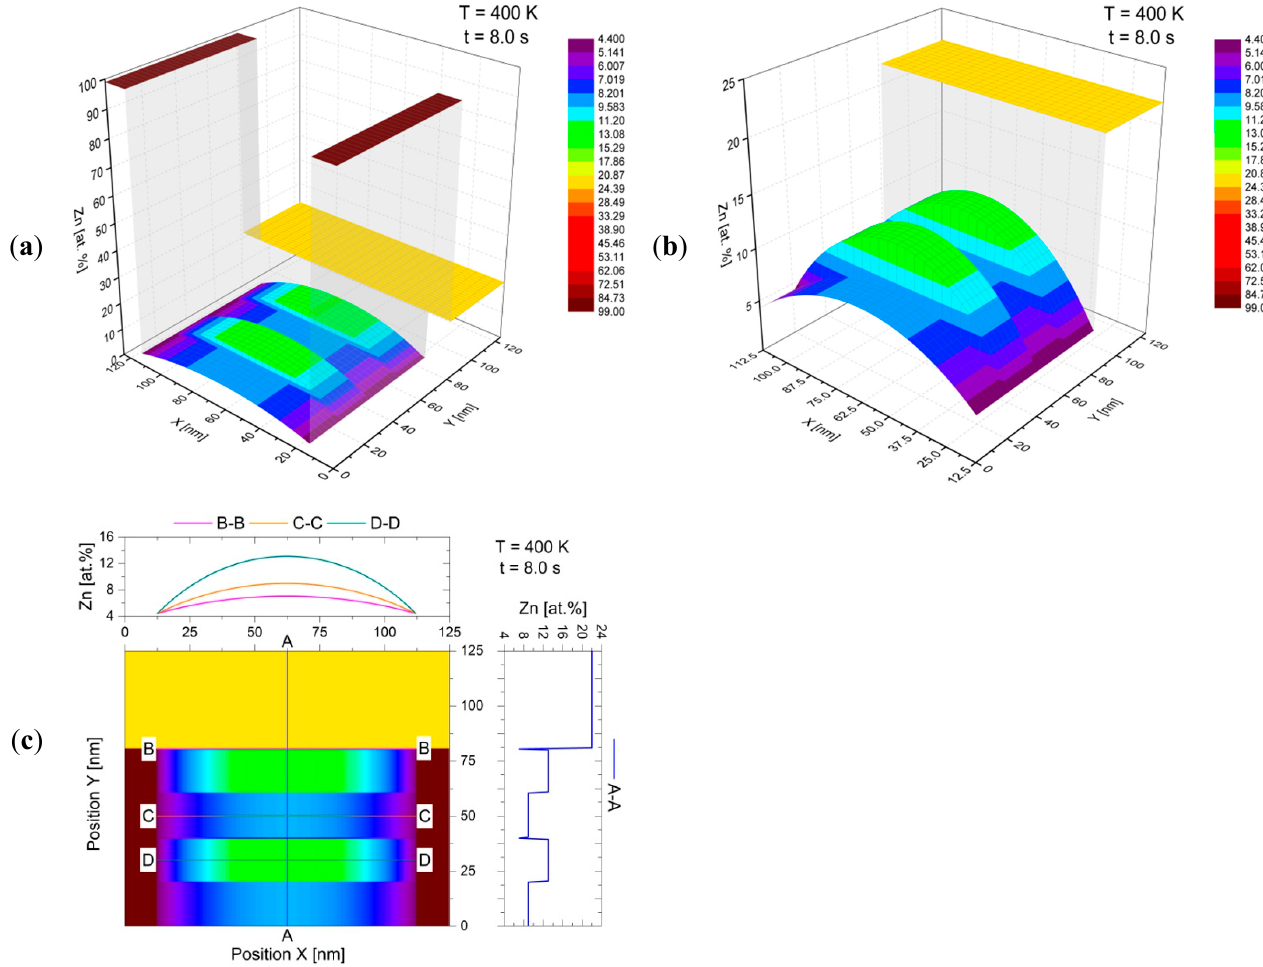
Figure 7. Simulation results after 8 s of DP reaction at 400 K (~127 °C) for a fixed RF migration velocity 𝑣 = 20 nm/s, in the form of: three-dimensional surface plots with the whole modelling area ( a ) and with the α lamella only ( b ); map with line markings of zinc concentration at several locations for the α lamella ( c ).